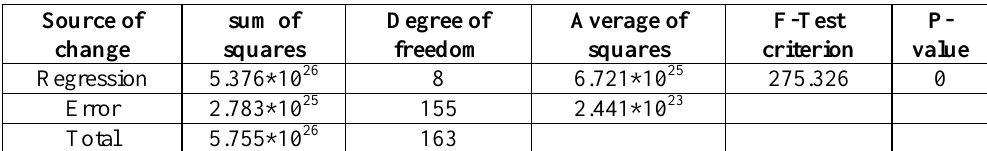
Degree of freedom